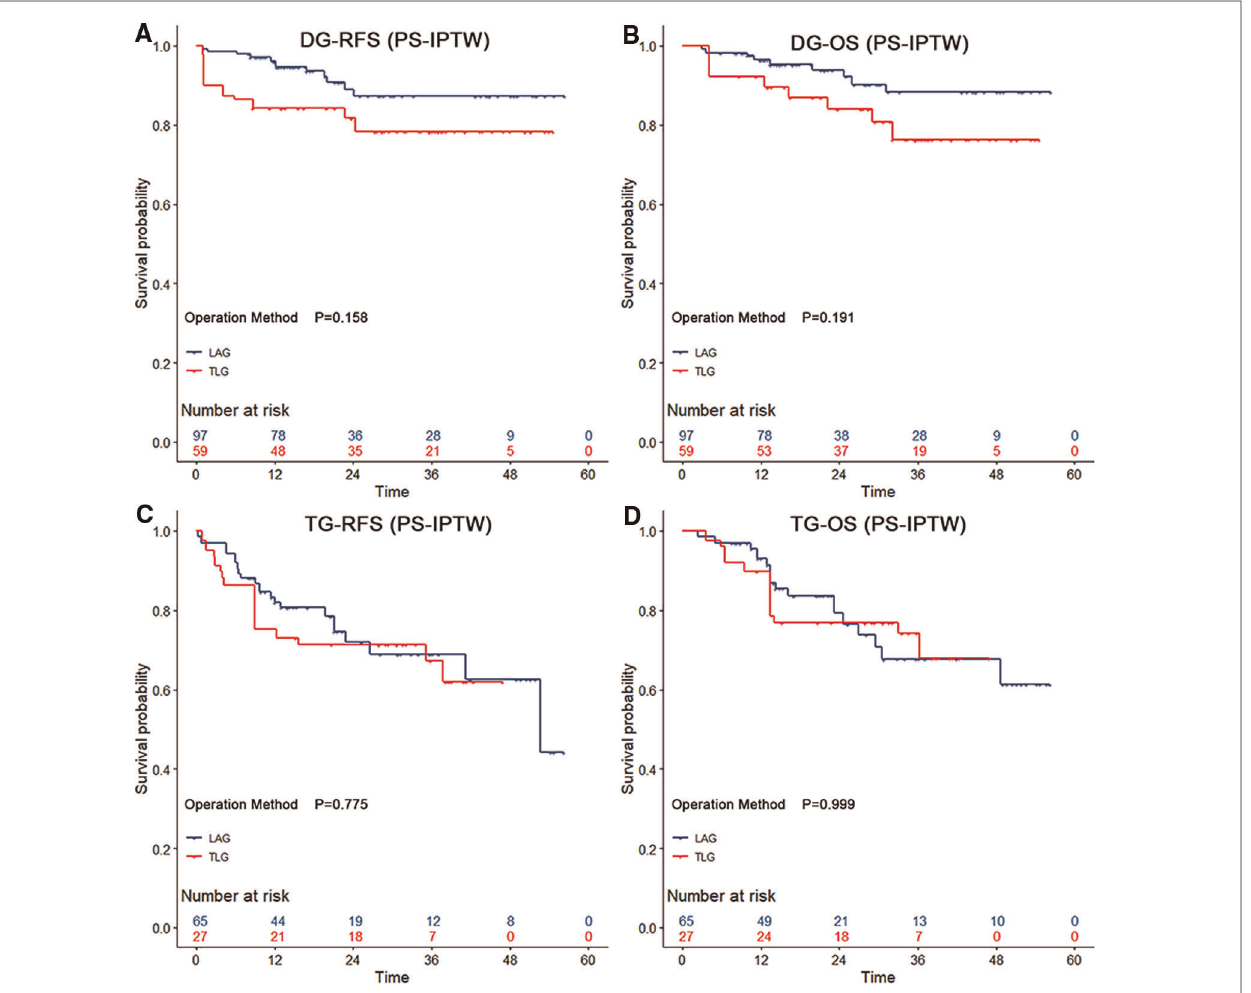
FIGURE 2 | The survival curves among distal and total gastrectomy after the propensity score-based inverse probability of treatment weighting. Both distal gastrectomy and total gastrectomy showed no signi fi cant difference in relapse-free survival and overall survival ( p >0.05 by the log-rank test). The risk tables show the actual number of patients with operation